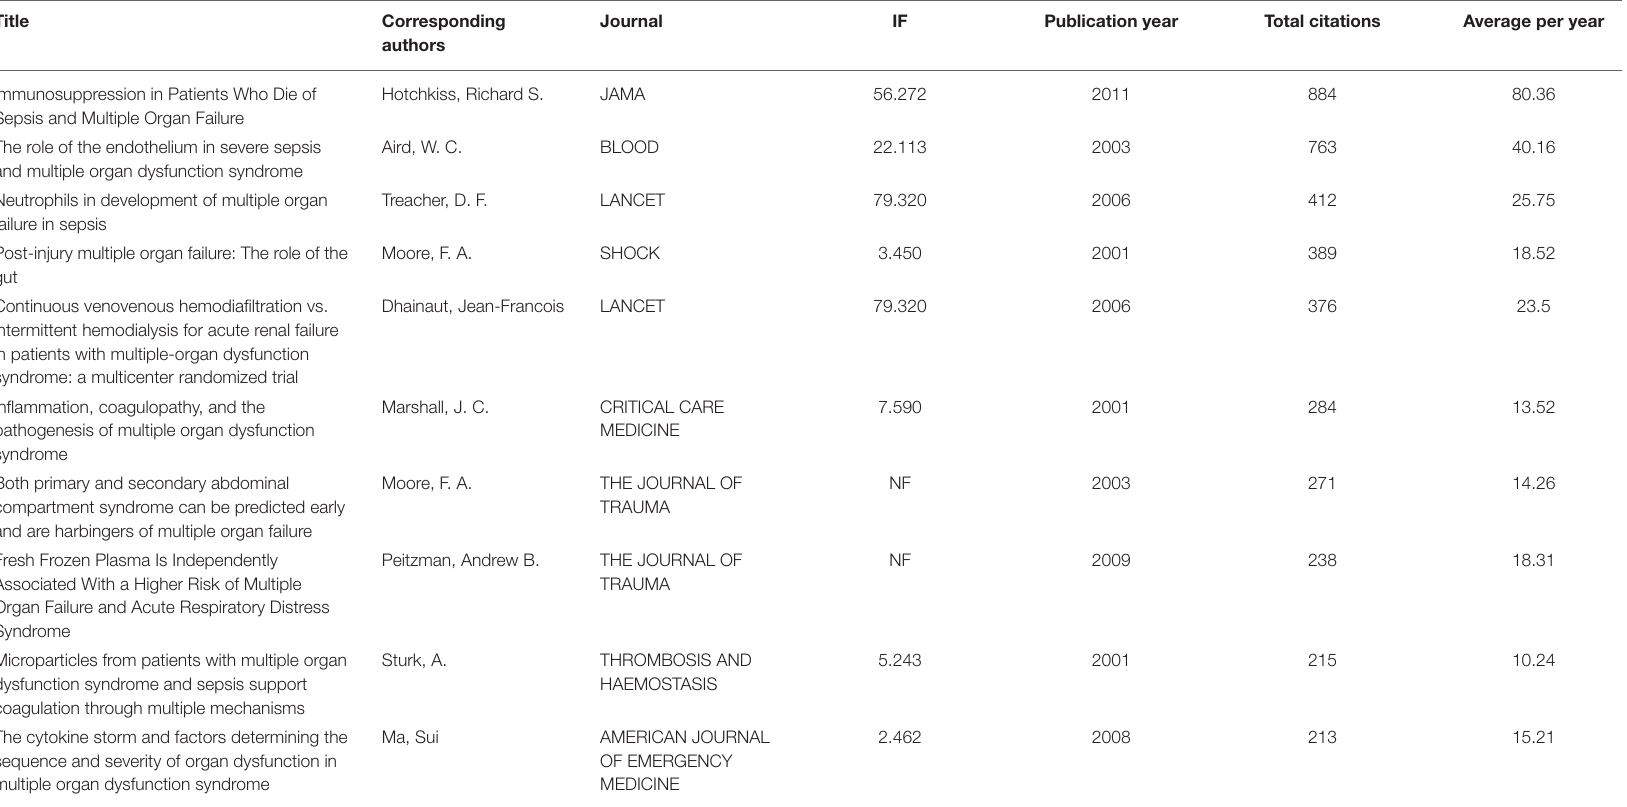
TABLE 1 | Top 10 high-cited papers related to